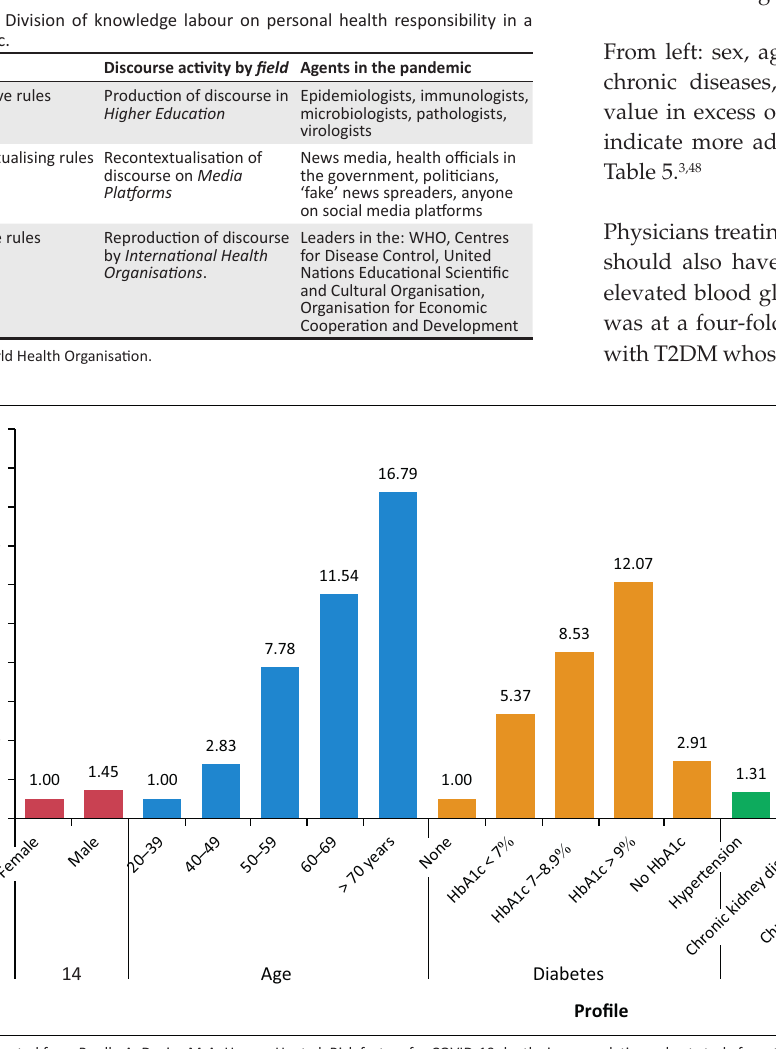
FIGURE 1: Hazard ratios for risk of fatal outcome in COVID-19 infections in the Western Cape. 66